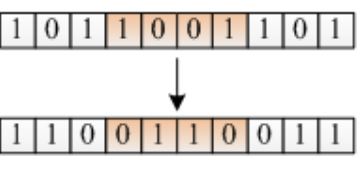
Figure 6. Mutation